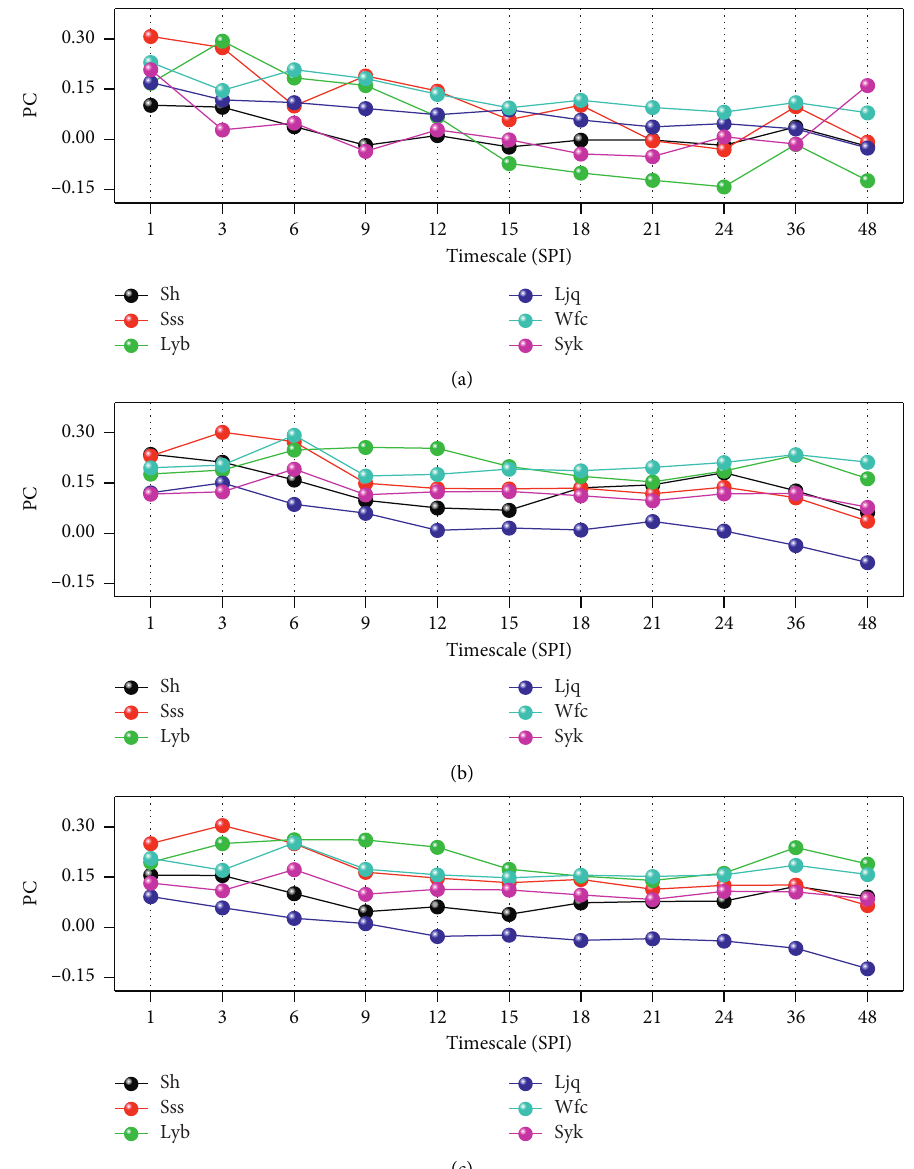
Figure 8: Pearson’s correlation coefficien between the SDI-1 series and the SPI series at different timescales for six